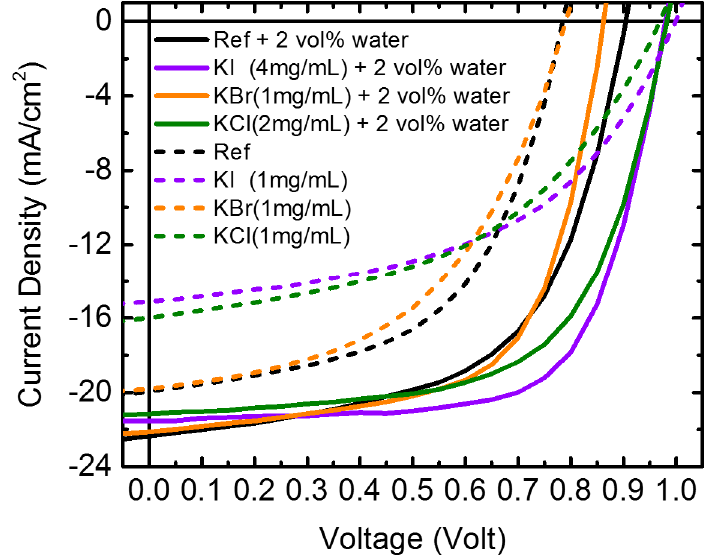
Figure 1. Photocurrent density–voltage (J–V) curves of perovskite solar cells prepared without and with water and/or potassium halide additives under their optimized concentrations.